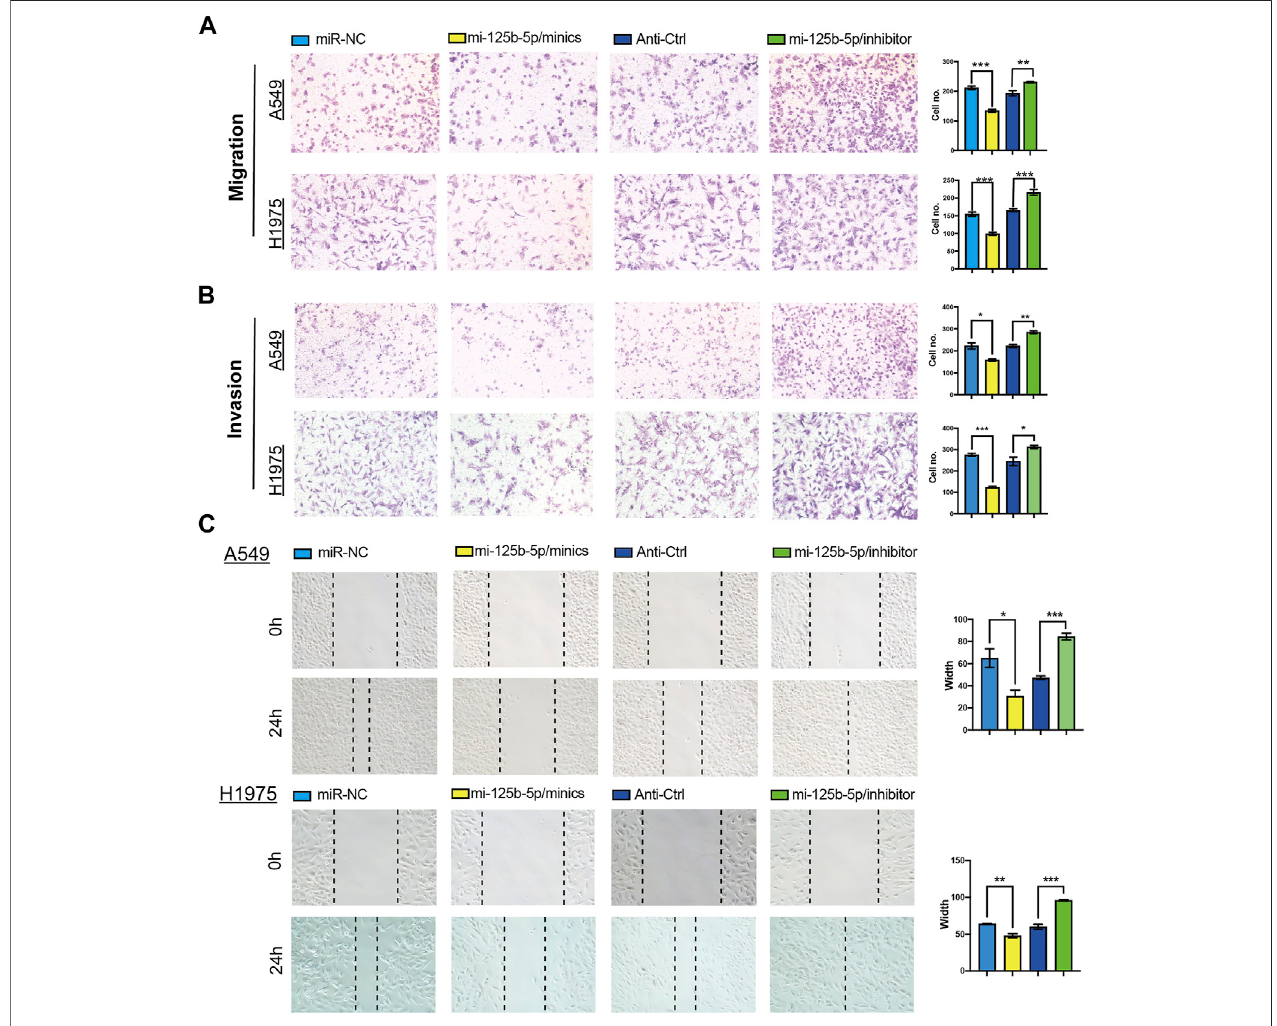
FIGURE 7 | Overexpression of miR-125b-5p inhibited lung adenocarcinoma (LUAD) migration and invasion. (A – C) Overexpression of miR-125b-5p on cell migration and invasion abilities examined by the Transwell and wound healing assays. Quanti fi cation data are also indicated. * p < 0.05, ** p < 0.01, *** p < 0.001.